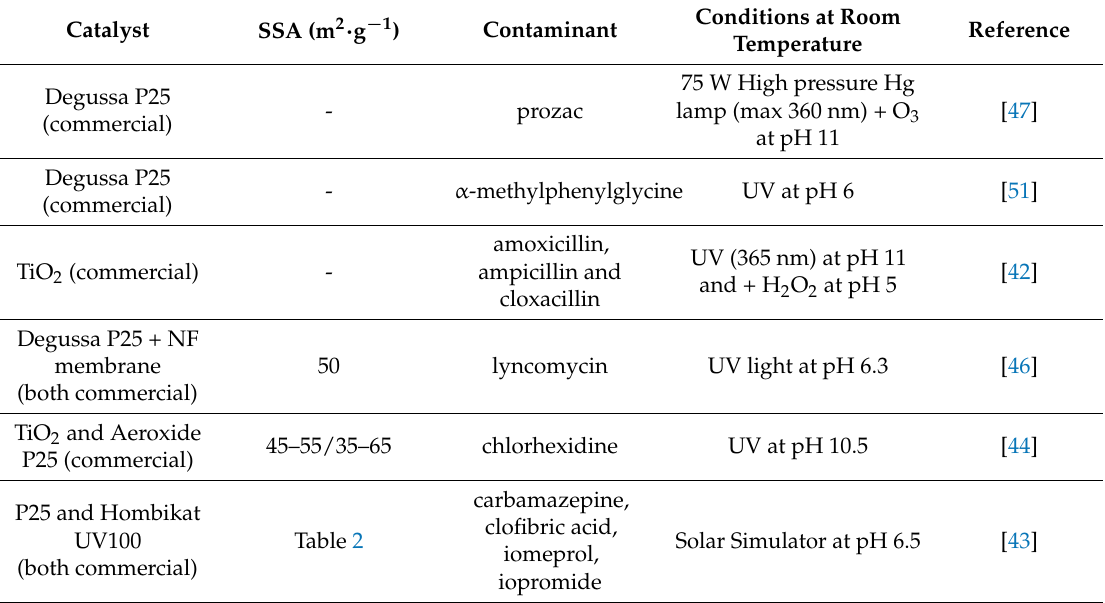
Table 3. Summary of the nanostructured catalysts, particles and contaminants. The pH reported refers to the optimum or initial